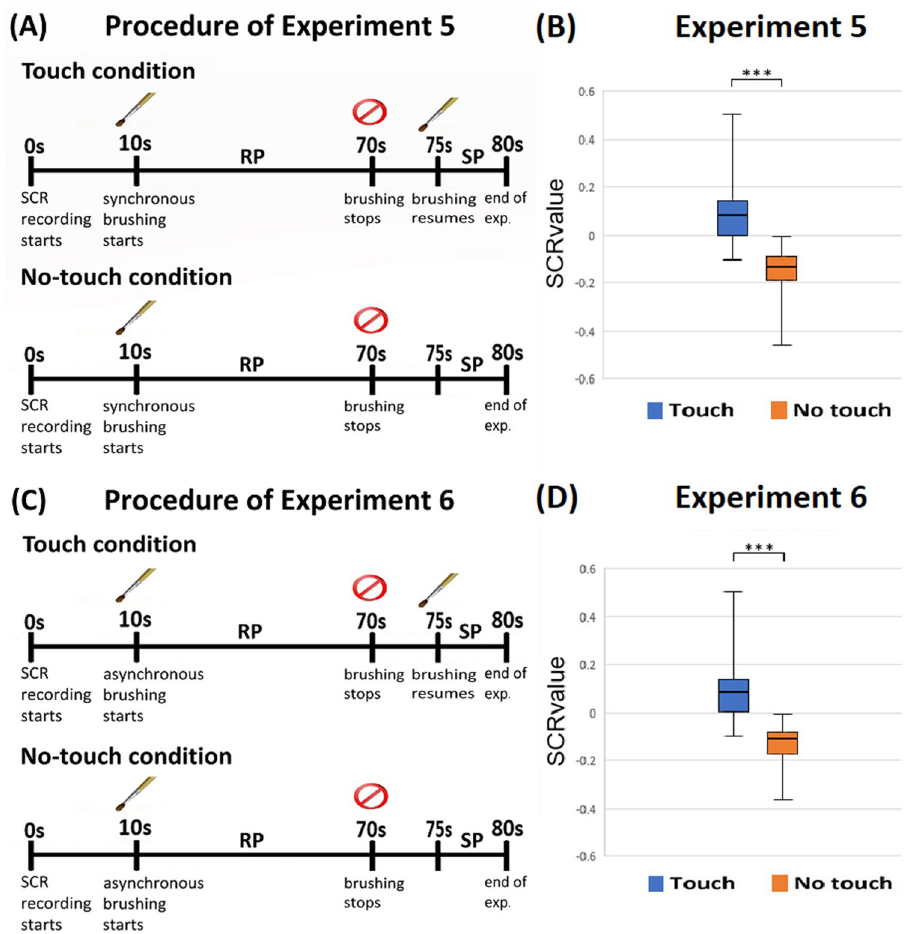
Figure 4. Procedures and Results of Experiments 5 and 6. ( A ) The schematic diagram of the procedures of Experiment 5. ( B ) The box chart of the SCR values of Experiment 5. ( C ) The schematic diagram of the procedures of Experiment 6. ( D ) The box chart of the SCR values of Experiment 6. The error bars represent the maximum/minimum value. SCR value = (∆SCR in SP)/(SCR value range in RP). Significance levels: * p < 0.05; ** p < 0.01; *** p <